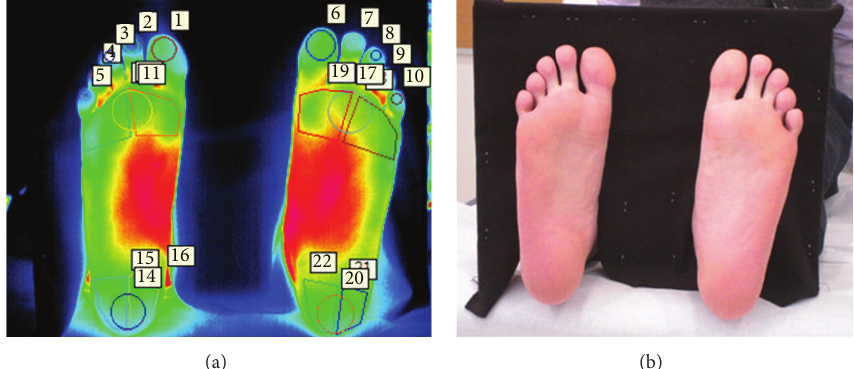
Figure 2: Participants were asked to keep their feet momentarily in slight dorsiflexion and pointing vertically upwards, while a thermal image (a) and a visual image (b) were acquired. Measurement regions were then annotated on the thermal image (a) for further analysis.